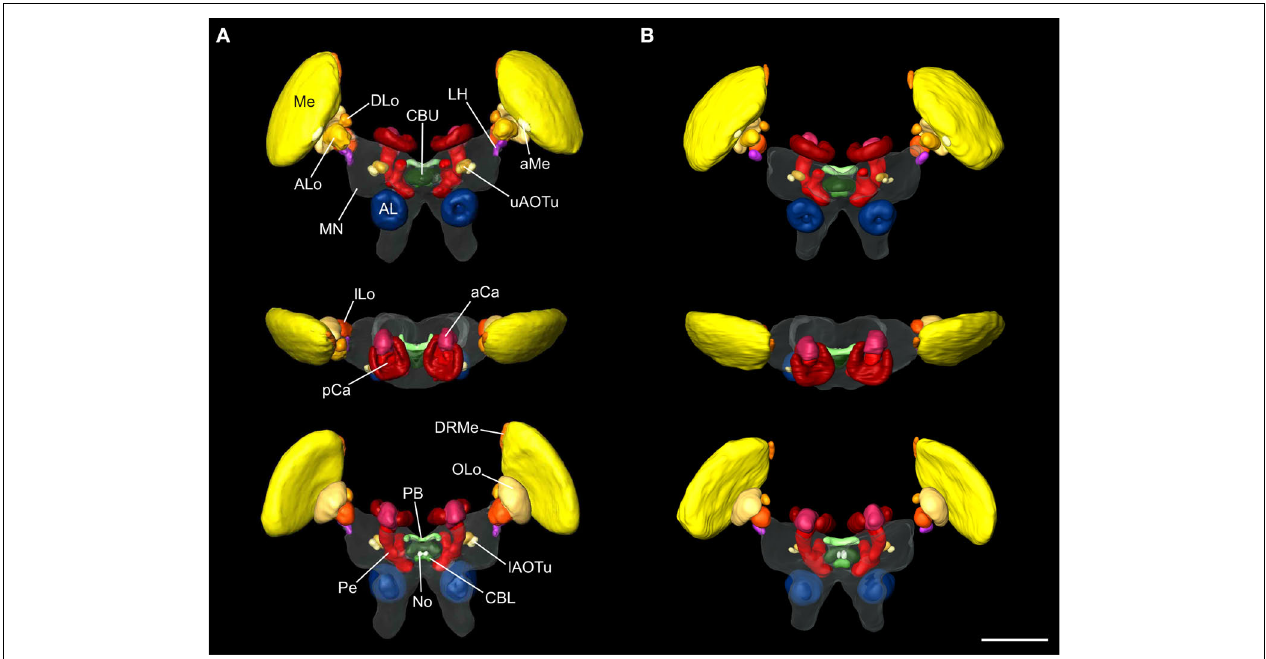
FIGURE 1 | Visual comparison of the 10-animal ISA and VIB whole standard brains of the desert locust Schistocerca gregaria . Surface reconstruction of 33 distinct neuropils plus a “midbrain neuropil” (MN, transparent) (A) ISA standard brain in anterior (top), dorsal (middle), and posterior (bottom) view (aCa, accessory calyx; AL, antennal lobe; ALo, anterior lobe of the lobula; aMe, accessory medulla; CBL, lower division of the central body; CBU, upper division of the central body; DLo, dorsal lobe of the lobula; DRMe, dorsal rim area of the medulla; ILo, inner lobe of the lobula; lAOTu,